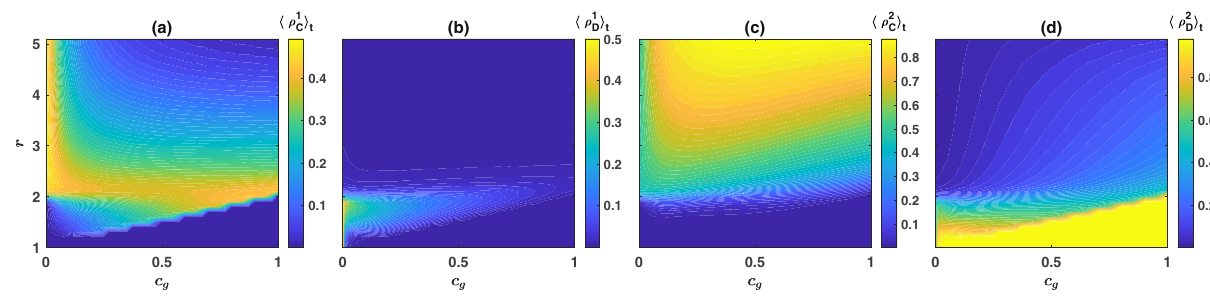
Fig. 4 The frequency of different strategies in the c g − r plane in a structured population. The time average frequencies of costly cooperators ( a ), costly defectors ( b ), non-costly cooperators ( c ), and non-costly defectors ( d ) in the c g − r plane are color plotted. The system shows a red queen dynamic in which cooperators only in the costly institution survive in large numbers (for smaller enhancement factors), or a black queen dynamic, where cooperators in both institutions survive and help each other to suppress defection (for larger enhancement factors). Parameter values: g = 5, nu = 10 − 3 , and π 0 = 2. The population resides on a 200×200 fi rst nearest neighbor square lattice with von Neumann connectivity and periodic boundaries. The simulation is performed for 5000 time steps starting from an initial condition in which all the individuals are defectors and prefer one of the two institutions at random. The time average is taken over the last 2000 steps.